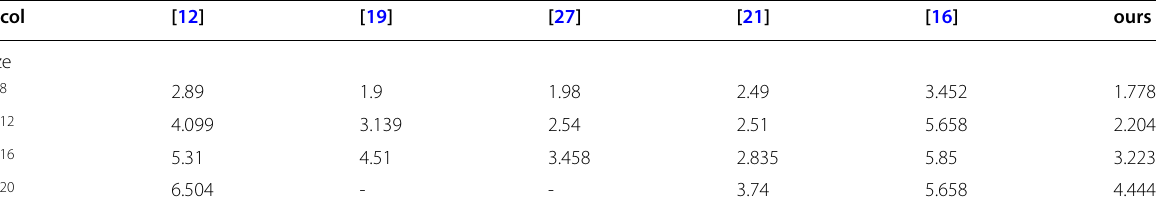
Table 5 Comparison of the runtime with related protocols Protocol